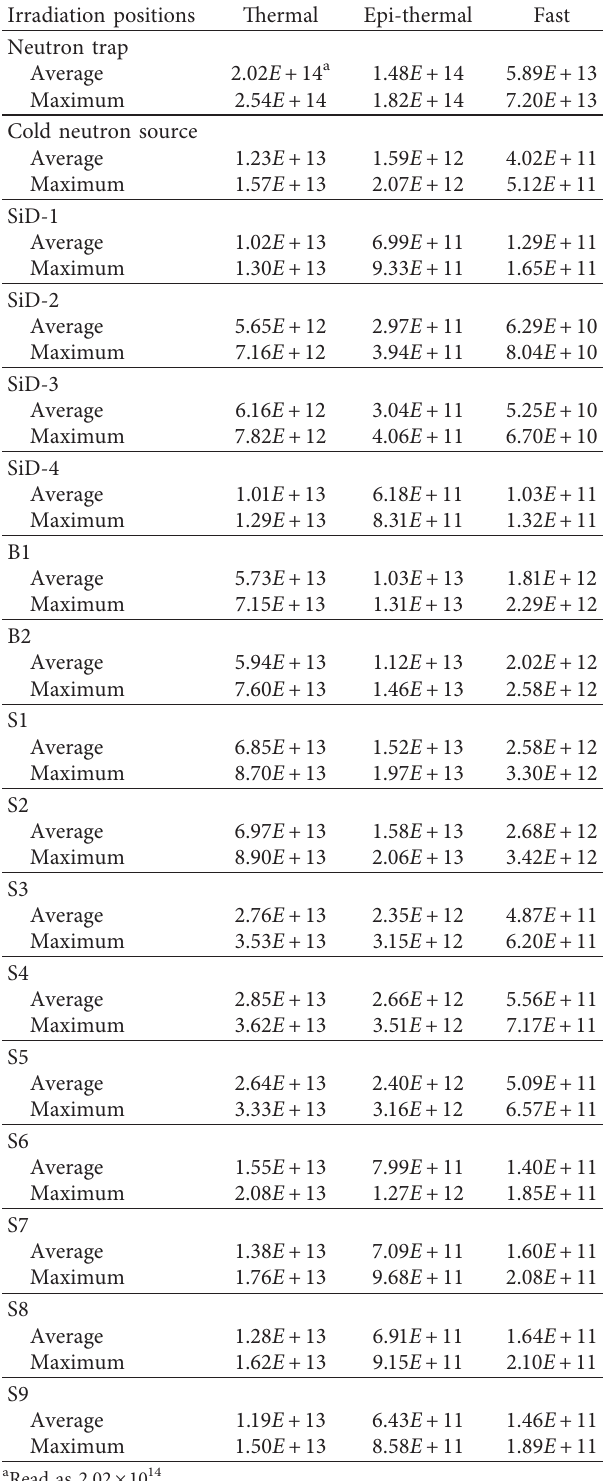
Table 4: Neutron fluxes (n · cm − 2 · s − 1 ) at irradiation positions in the reactor core and